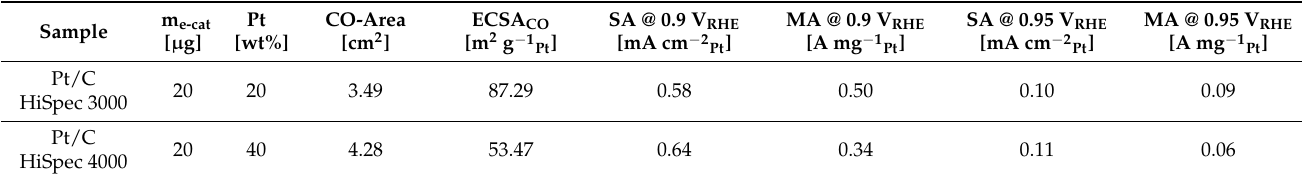
Table 3. Results of RDE-CV and in-situ CV analysis of the used catalyst powders.